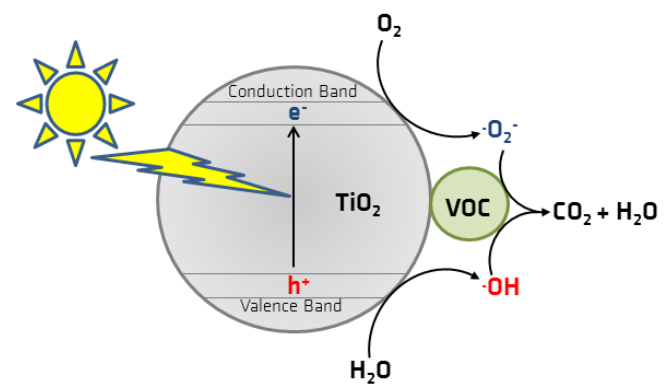
Figure 1. Photocatalytic degradation mechanism.